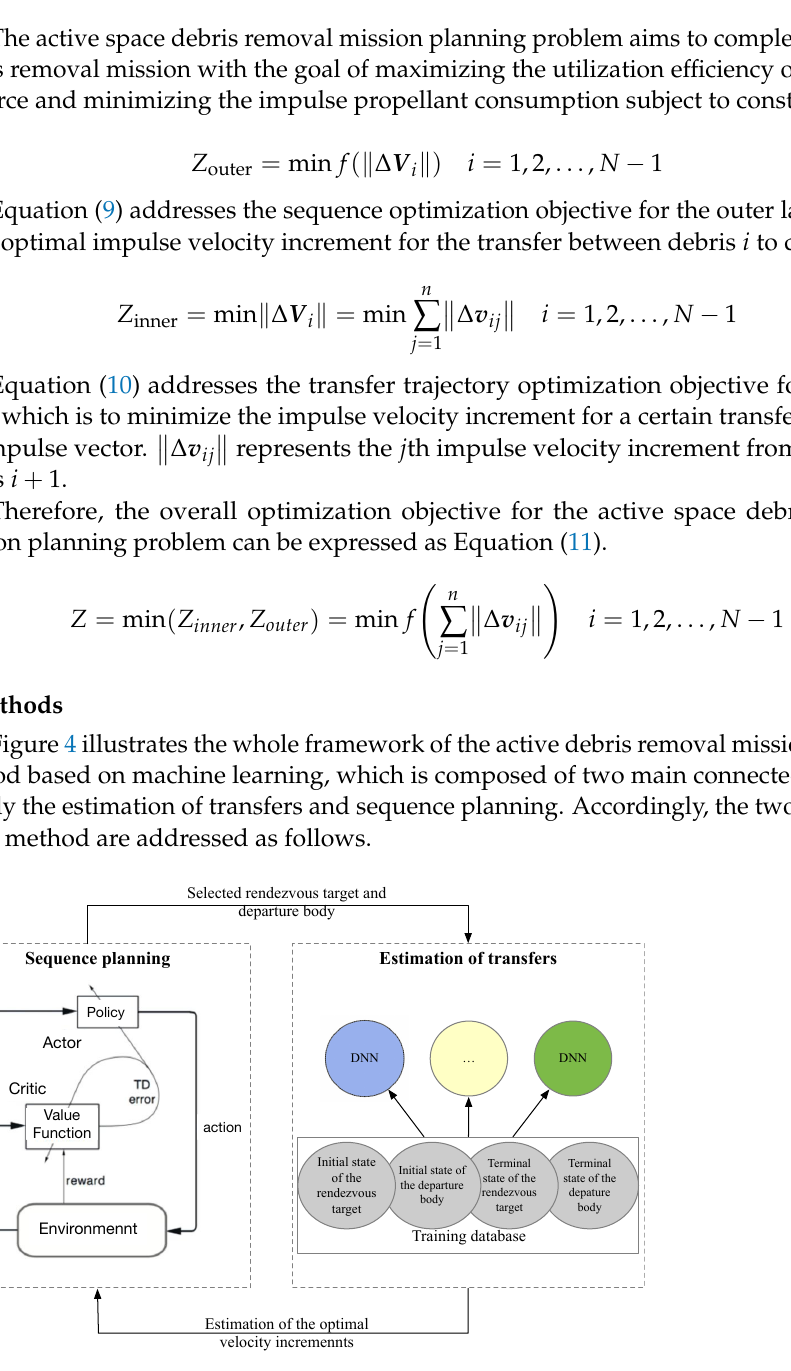
Figure 4. Framework of the active debris removal mission planning method based on machine learn-